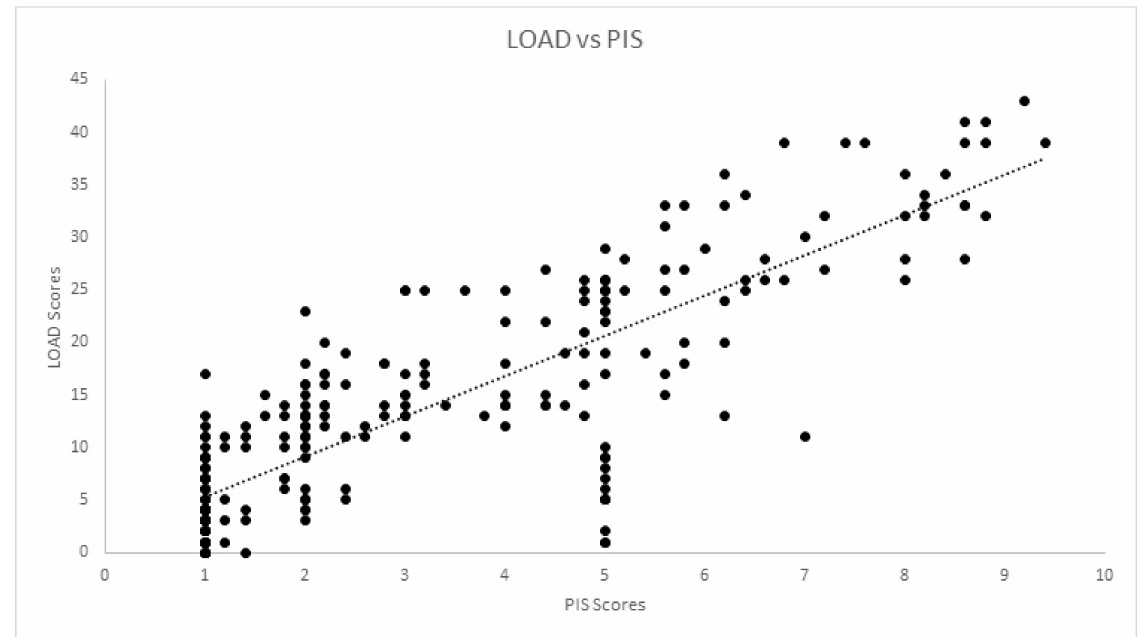
Figure 3. Scatterplot of LOAD (Liverpool Osteoarthritis in Dogs) and PIS (Pain Interference Score) in the longitudinal cohort. A significant strong correlation was observed (r = − 0.844, p < 0.01).